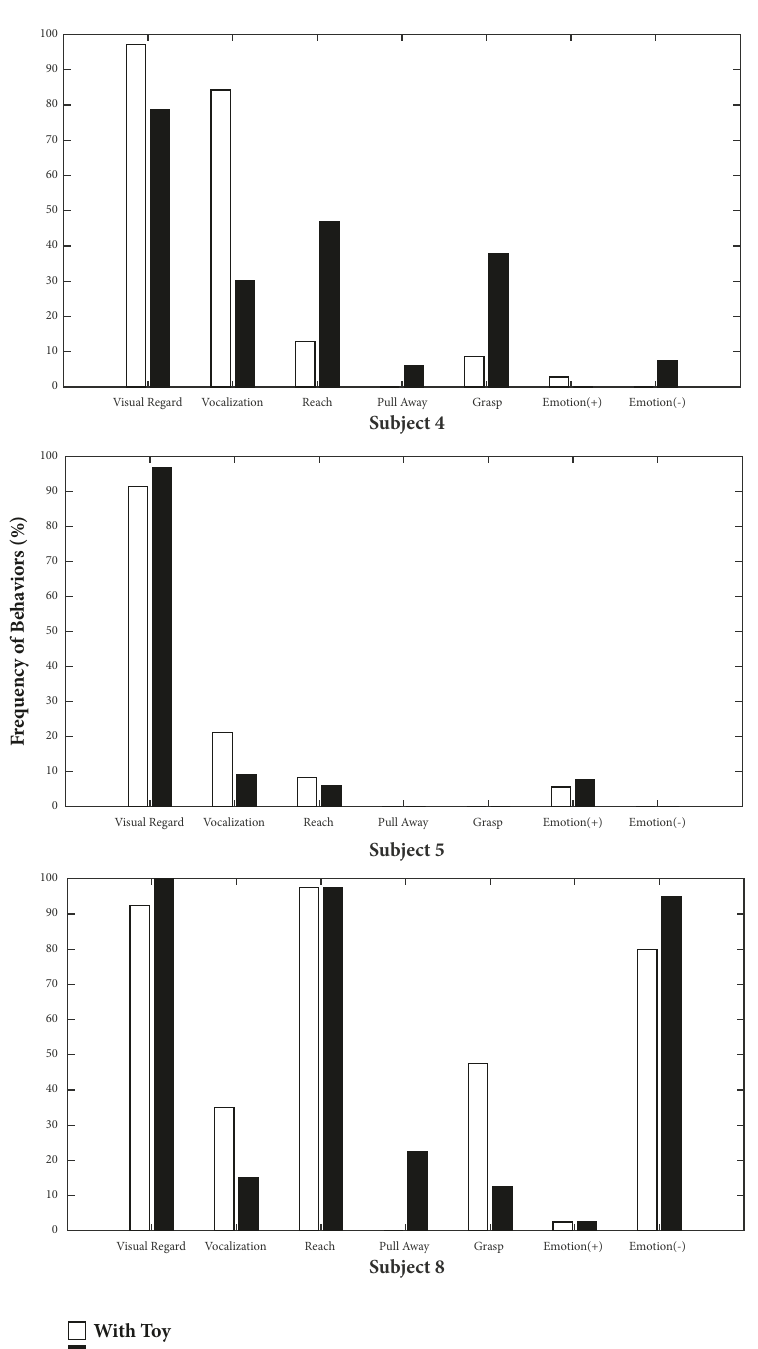
Figure 10: Results for Subjects 4, 5, and 8, which show a higher level of interaction with the switch-adapted toy over the SAR for all three